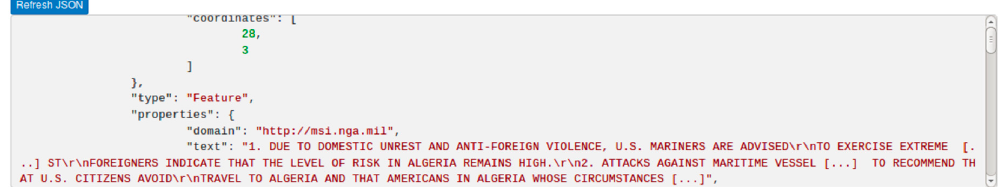
Figure 6. JSON exporter tool. Once a user is satisfied with their query and information displayed, an export of this data can be generated using this tool. JSON data can easily be brought into a statistical analysis environment such as R, or converted to other formats.